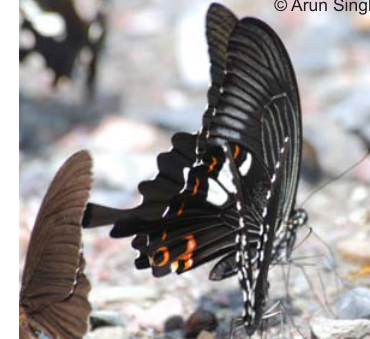
Image 13. Lesser Zebra Graphium macareu